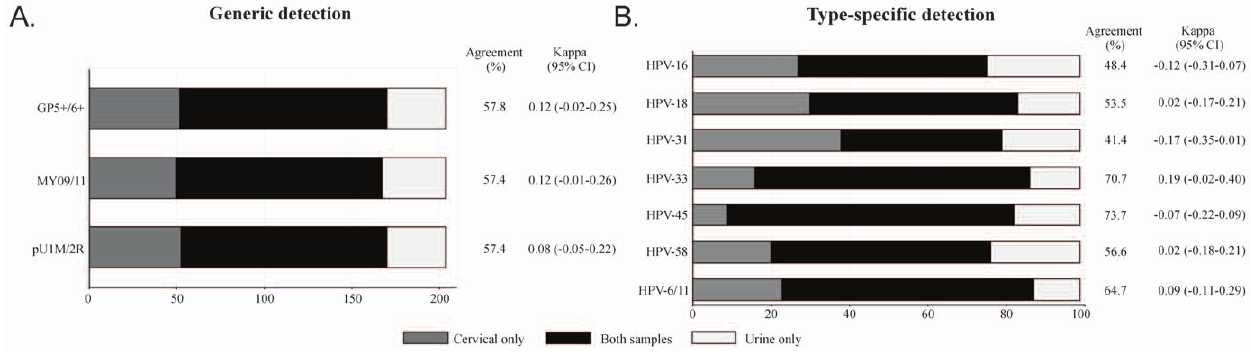
Figure 3. Agreement between generic and type-specific detection in cervical and urine samples taken from HIV-positive women.